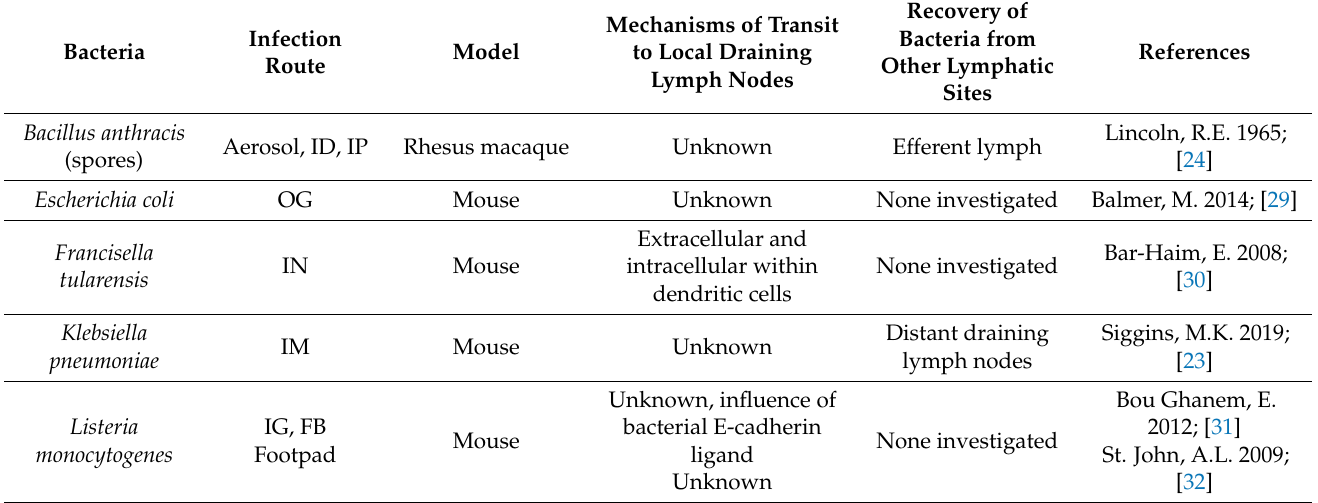
Table 1. Studies demonstrating the recovery of bacteria from the local draining lymph nodes following